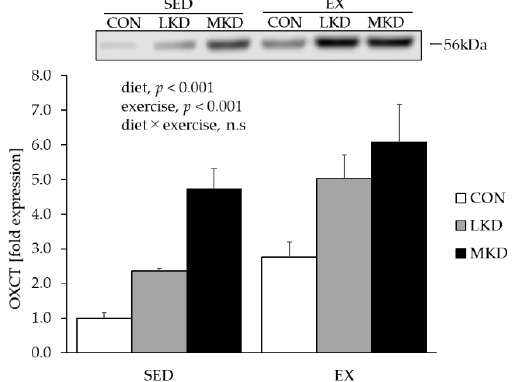
Figure 3. Protein expression of OXCT in epitrochlearis muscle tissue. Two-way ANOVA was performed, followed by a Tukey–Kramer multiple-comparison test. Values are means ± SEM, n = 7; n.s., not significant. A representative western immunoblot image is shown.